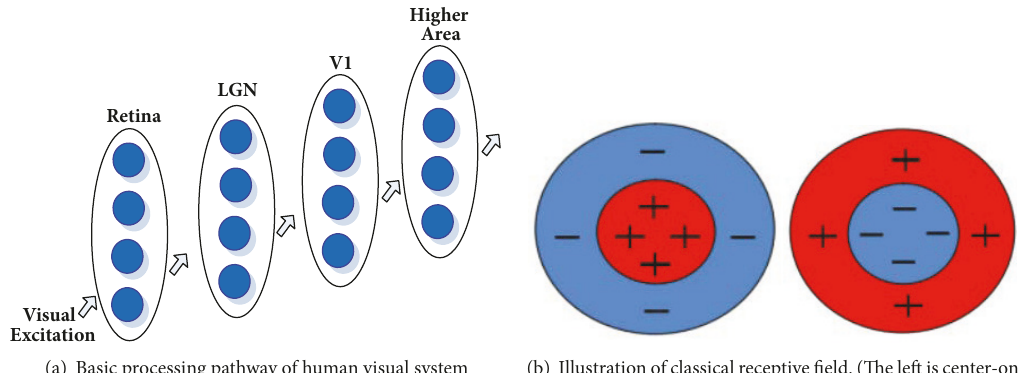
(b) Illustration of classicalreceptive field. (The left is center-on LGN cells and the right is center-off LGN cells.) Figure 2: Illustration of Basic Human Receptive Field (RF).